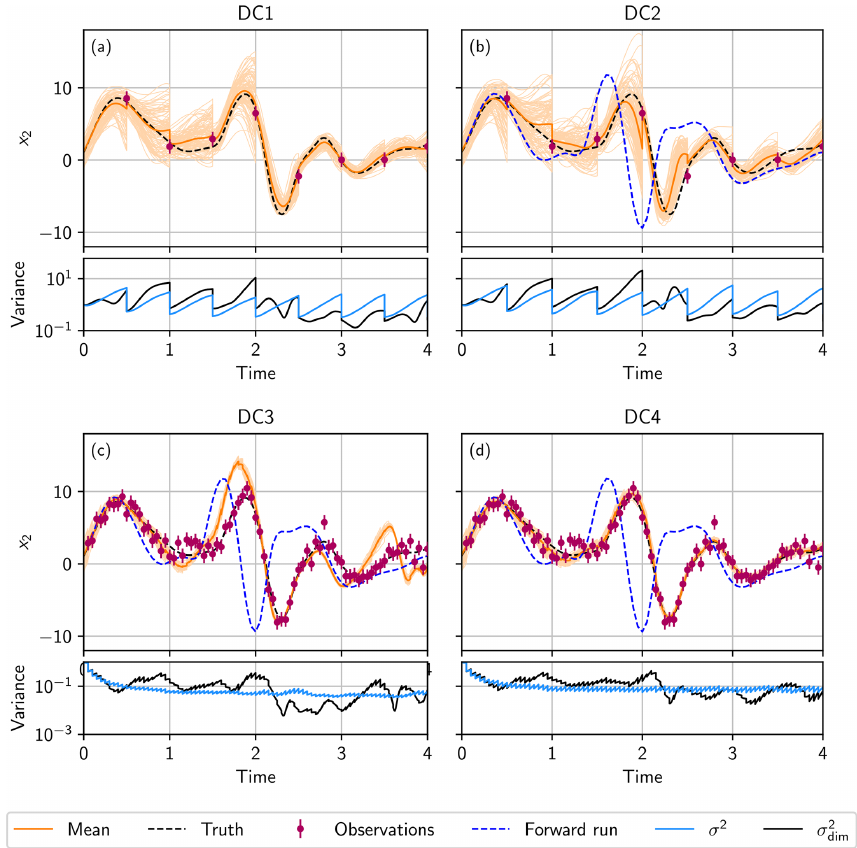
Figure 2. State estimation in a divergent system. (a) Divergent case 1 (DC1), where the ensemble is propagated with the same parameter as the truth ( F = 8). (b) Divergent case 2 (DC2), where the ensemble is propagated with F = 10 instead. (c) Divergent case 3 (DC3), where the ensemble is propagated with F = 10, and the observation interval is reduced to (cid:49)t Obs = 0 . 05. (d) Divergent case 4 (DC4), where the parameter error is represented by the ensemble, using N ( 10 , 2 2 ) for the reduced observation interval of (cid:49)t Obs = 0 . 05. In the upper plots (a–d) , the ensemble mean (orange line) and the ensemble (light orange lines) in the data assimilation run for state dimension 2 x 2 , together with the observations (purple) generated from the truth (black dashed line). Panels (b–d) additionally show a single forward run (blue dashed line) using a wrong parameter F = 10 starting from the true initial condition. In the lower plots (a–d) , the mean variance σ 2 of the ensemble over all dimensions (light blue line) and variance σ 2 of state dimension 2 (black dim